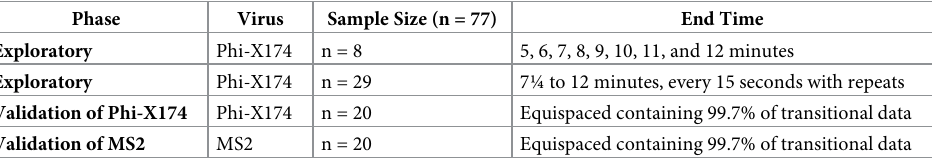
Table 4. Predetermined viral test